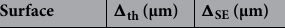
Table 2. Comparison of numerical and theoretical penetration of the bottom meniscus of the droplet.